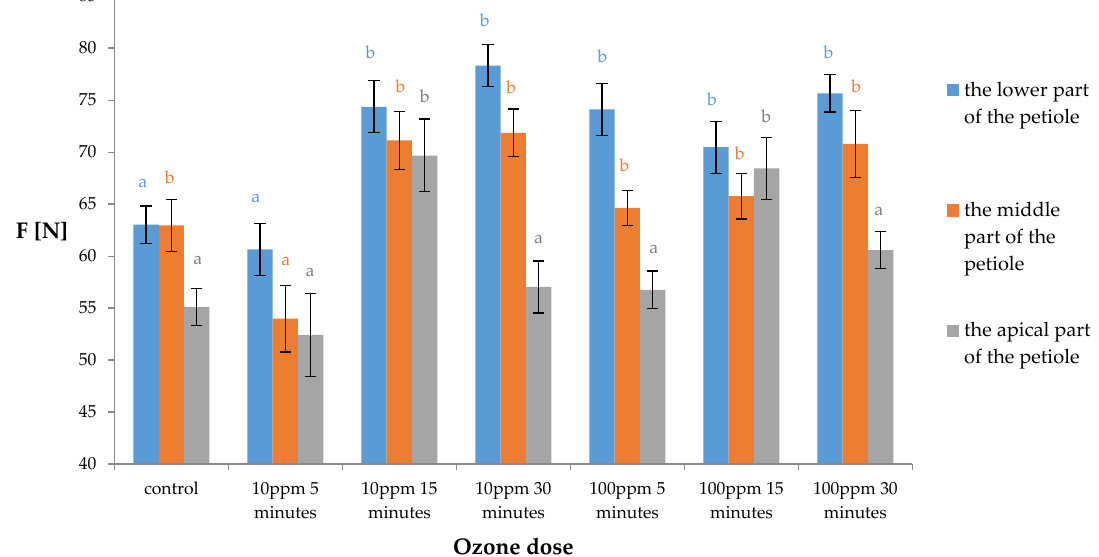
Figure 3. Mean values of the force needed to puncture the skin with ϕ = 6 mm indenter, on the flat side of rhapontic rhubarb petioles. Differences in the results between the punching force values for individual variants are marked with different small letters, p < 0.05.